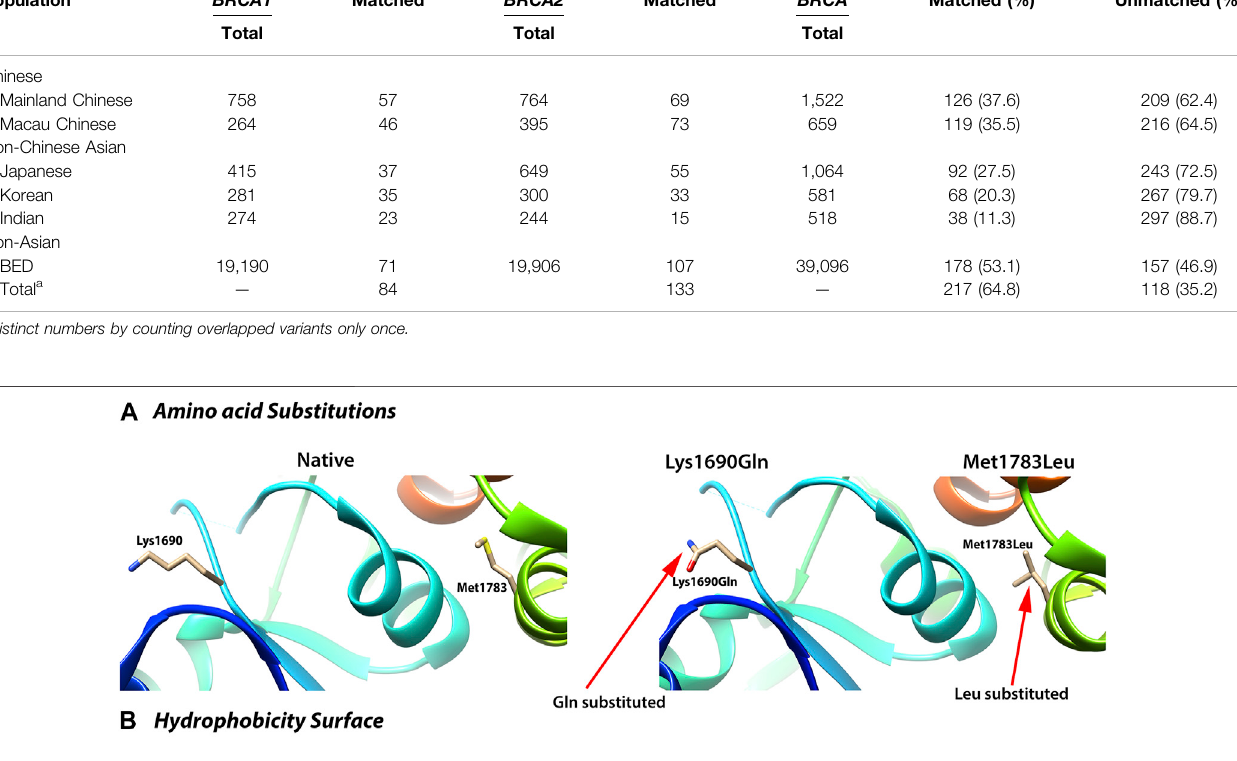
TABLE 2 | Comparison between Taiwanese population and other populations.